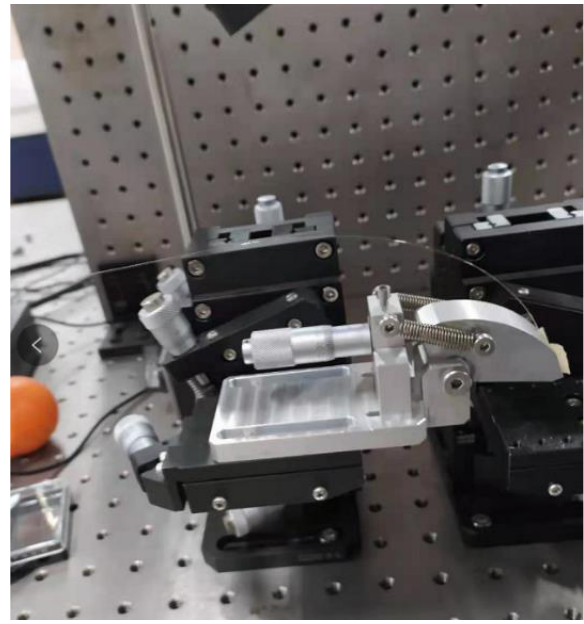
Figure 5. Experimental setup of turntable.